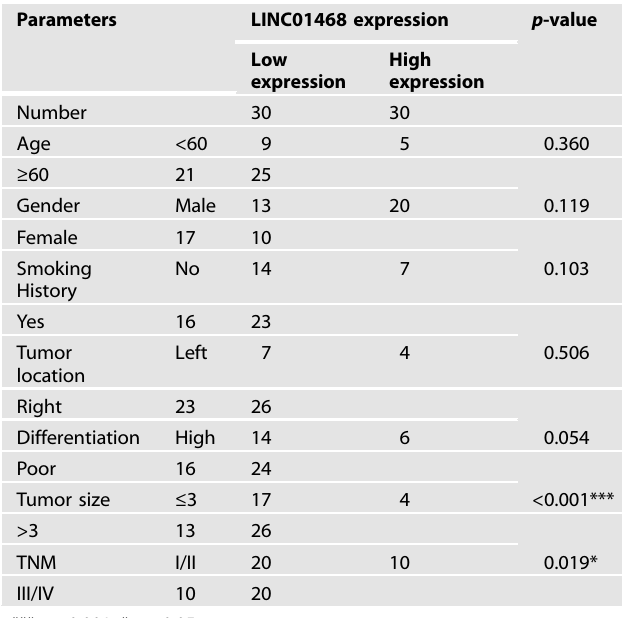
Table 1. The association between LINC01468 expression and the clinicopathologic characteristics of LUAD patients was demonstrated. The association between LINC01468 expression and the clinicopathologic characteristics of lung cancer patients.